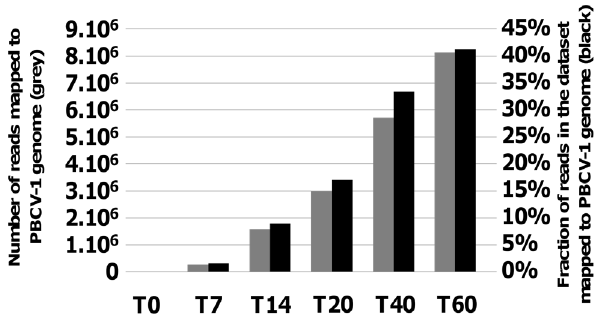
Figure 1. Distribution of reads mapped on the PBCV-1 genome. The grey bar is the number of reads mapped to the PBCV-1 genome and the black bar is the percentage of the total reads that map to the PBCV-1